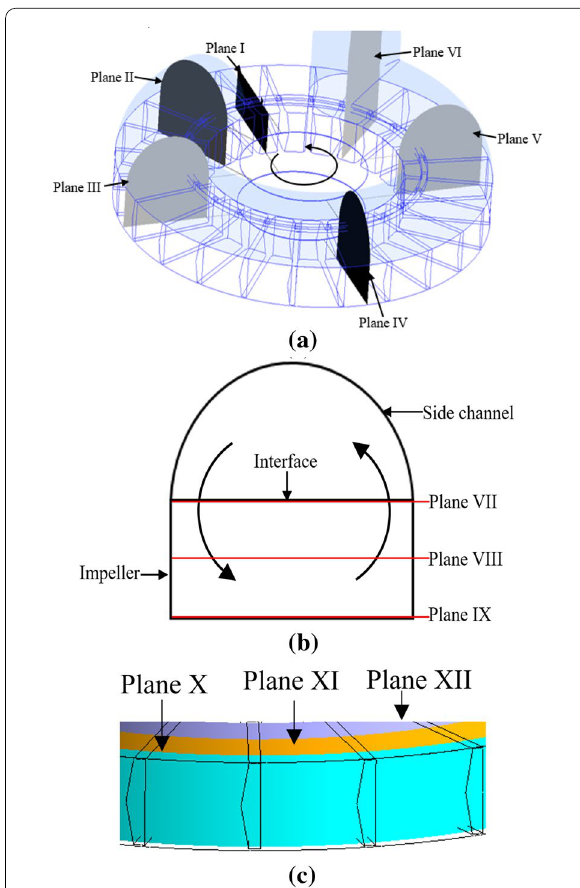
Figure 12 Positions of different planes ( a ) longitudinal, ( b ) axial, and ( c )